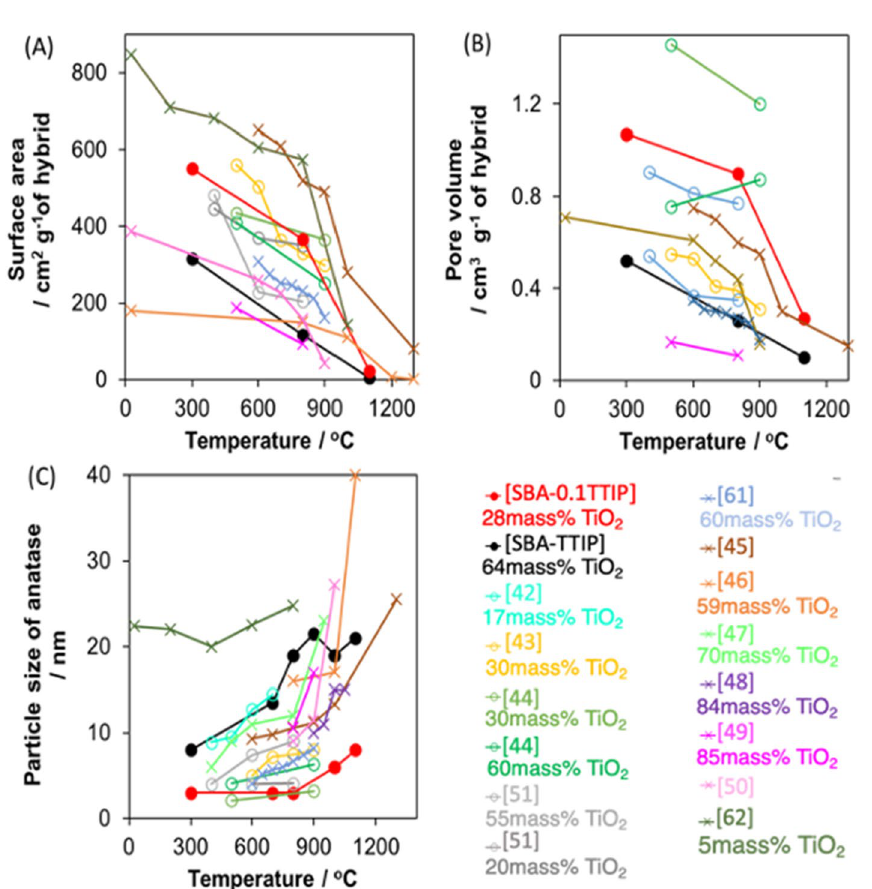
Figure 9. The relationship between ( A ) BET surface area, ( B ) pore volume and ( C ) particle size of anatase as a function of the heat treatment temperature where -o- represents those prepared by impregnation method and -x- represents those prepared by co-condensation method.